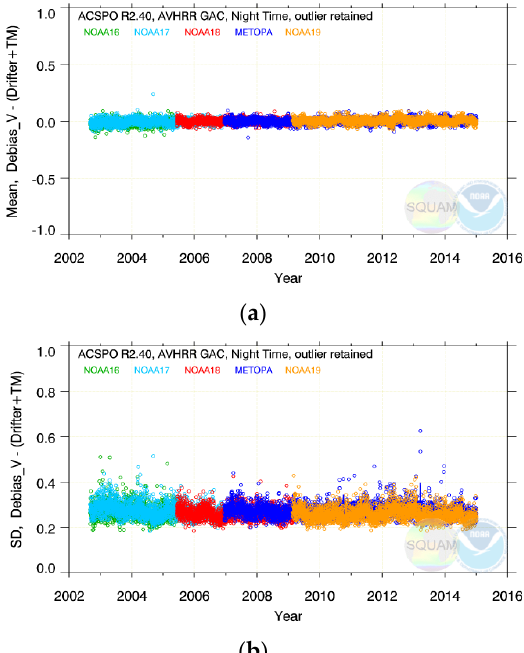
Figure 7. ( a ) Biases and ( b ) SDs of RAN1 SST re-plotted from Figures 3a and 4a but after applying the Sensor-Specific Errors Statistics (SSES) bias correction.